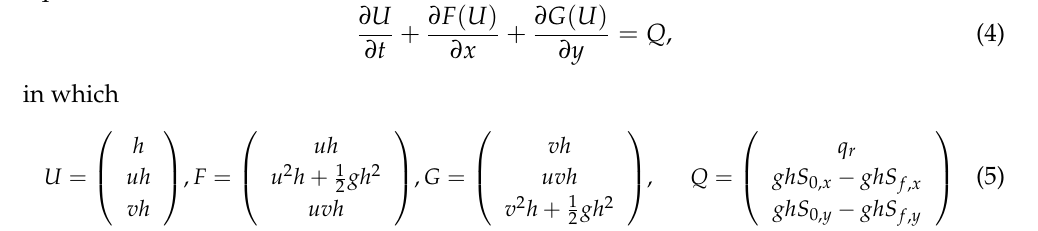
Figure 7. Validation for 3D road surface measurement.